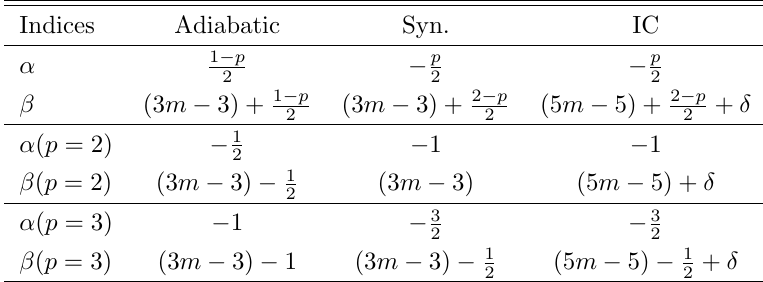
Table 1: Characteristics of the synchrotron emission from young SNe ( L ν ∝ ν α t β ), for the adiabatic limit and for the synchrotron and IC cooling limits, respectively (Maeda, 2013a).